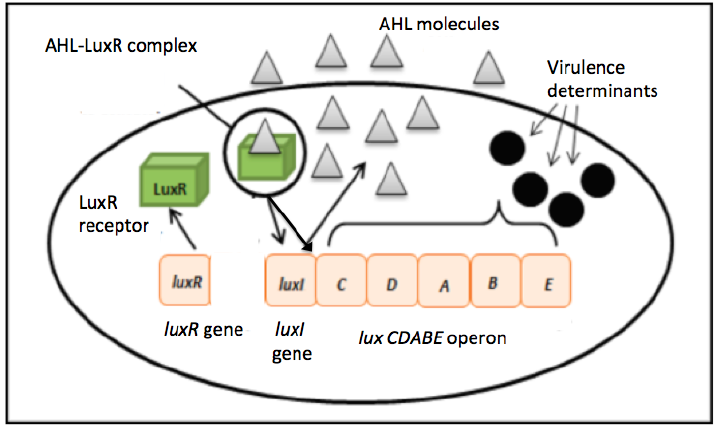
Figure 1. Autoinducer type 1 quorum sensing signal system in Gram-negative bacteria that employ LuxI/LuxR complex for